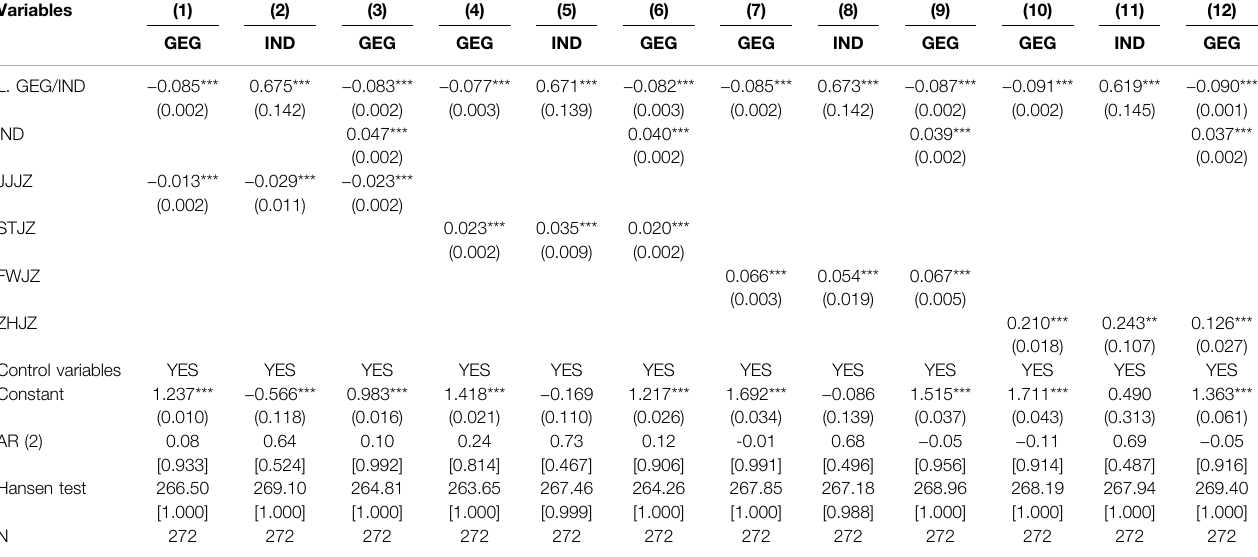
TABLE 6 | Role mechanism of industrial structural upgrading results.